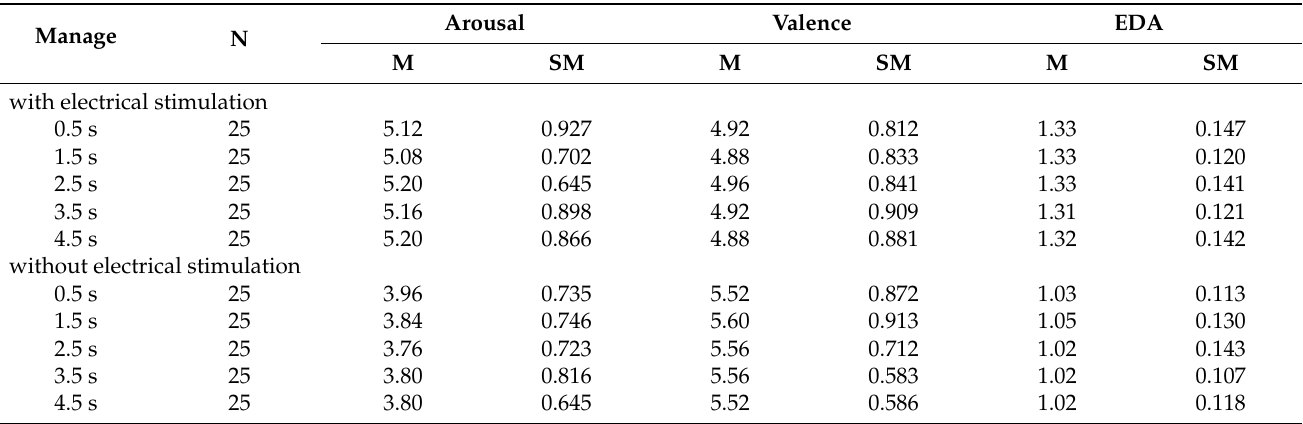
Table 1. Arousal, valence, and EDA were measured in5 target durations repeated with and without electrical stimulation.